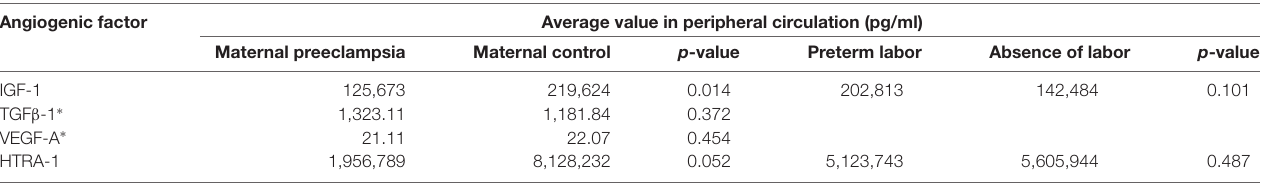
preterm labor. ∗ Proteins followed by an asterisk in the table are Luminex based versus the others which are ELISA based.